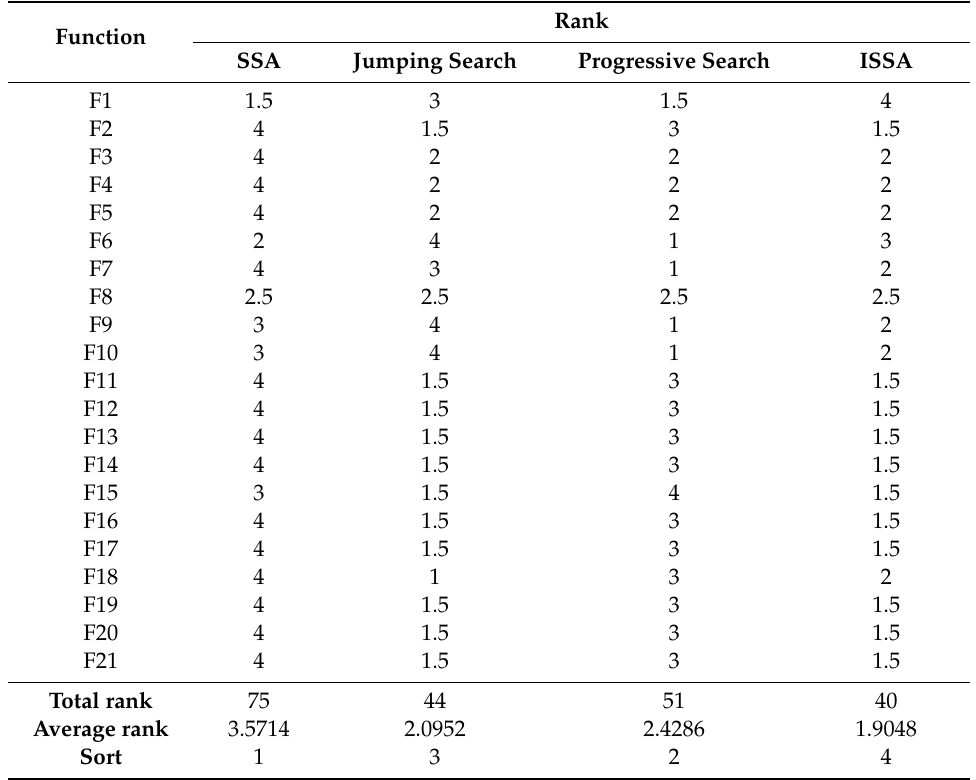
Table 6. The results of the Friedman test.